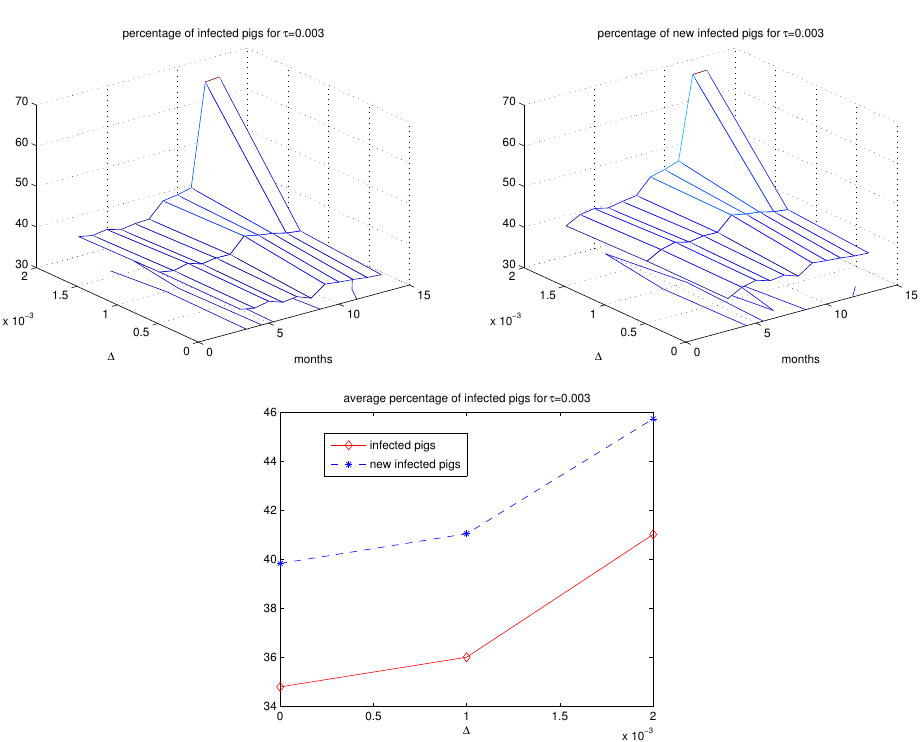
Fig. 14 Top. Left: Percentage of infected pigs evolution in case of bad implementation of the vaccine. Here we fix the value of external contamination rate at τ = 0 . 003. Right: The same figure for new infected pigs. Bottom. Averages in time as function of ∆ of the percentage of infected pigs evolution in case of bad implementation of the vaccine. Here we fix the value of external contamination rate at τ = 0 .